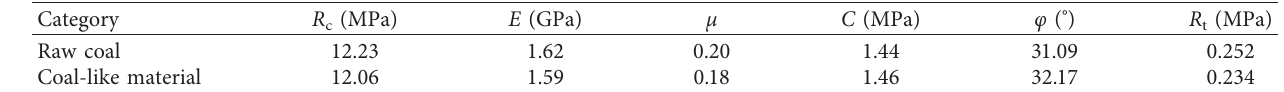
Table 1: Comparison of mechanical properties between raw coal and coal-like